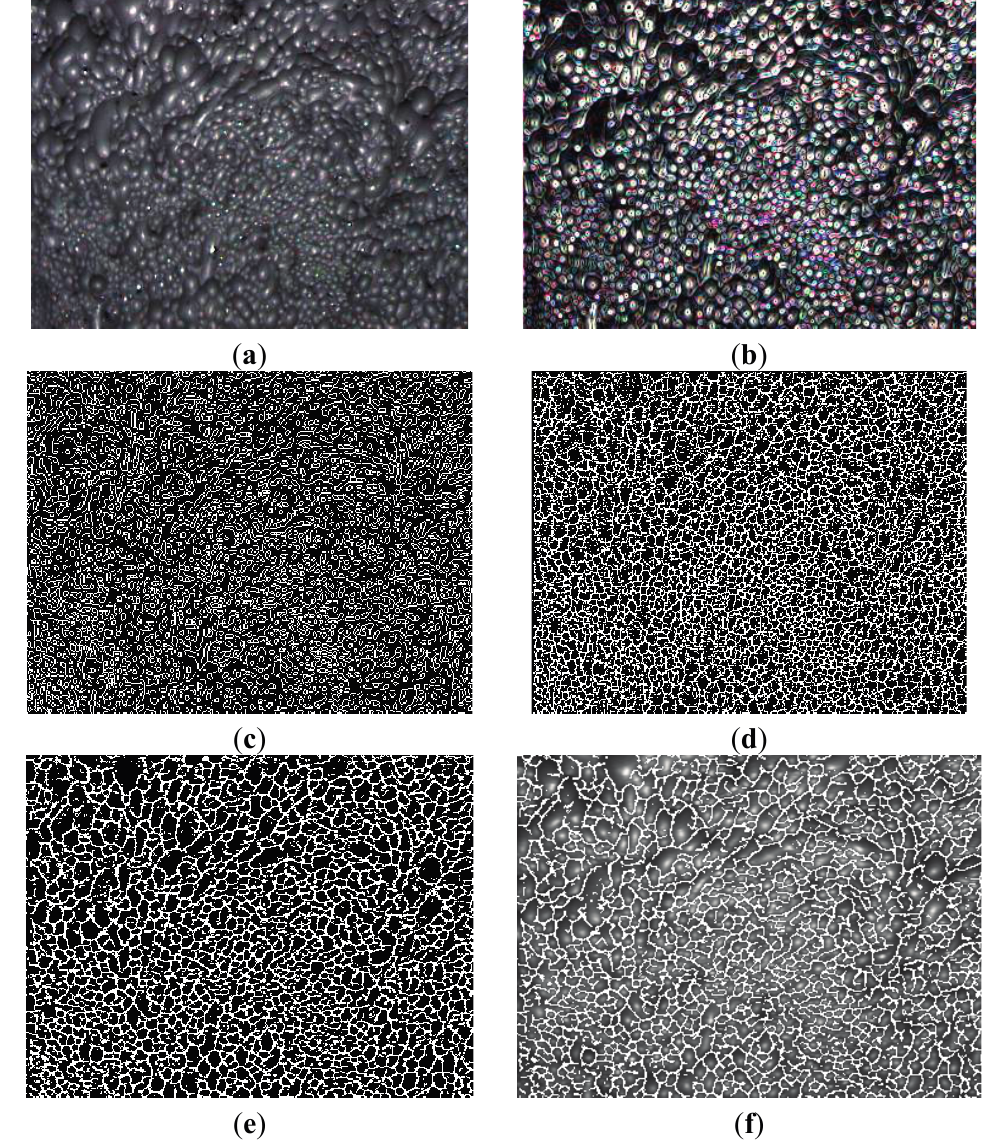
Figure 13. Comparison between the proposed edge detection algorithm and others (for the image of non-large bubbles). (a ) Original image; ( b ) Sobel result; ( c ) Canny result; ( d ) Valley-edge result; ( e ) New algorithm result; ( f ) Result of overlap (e) and